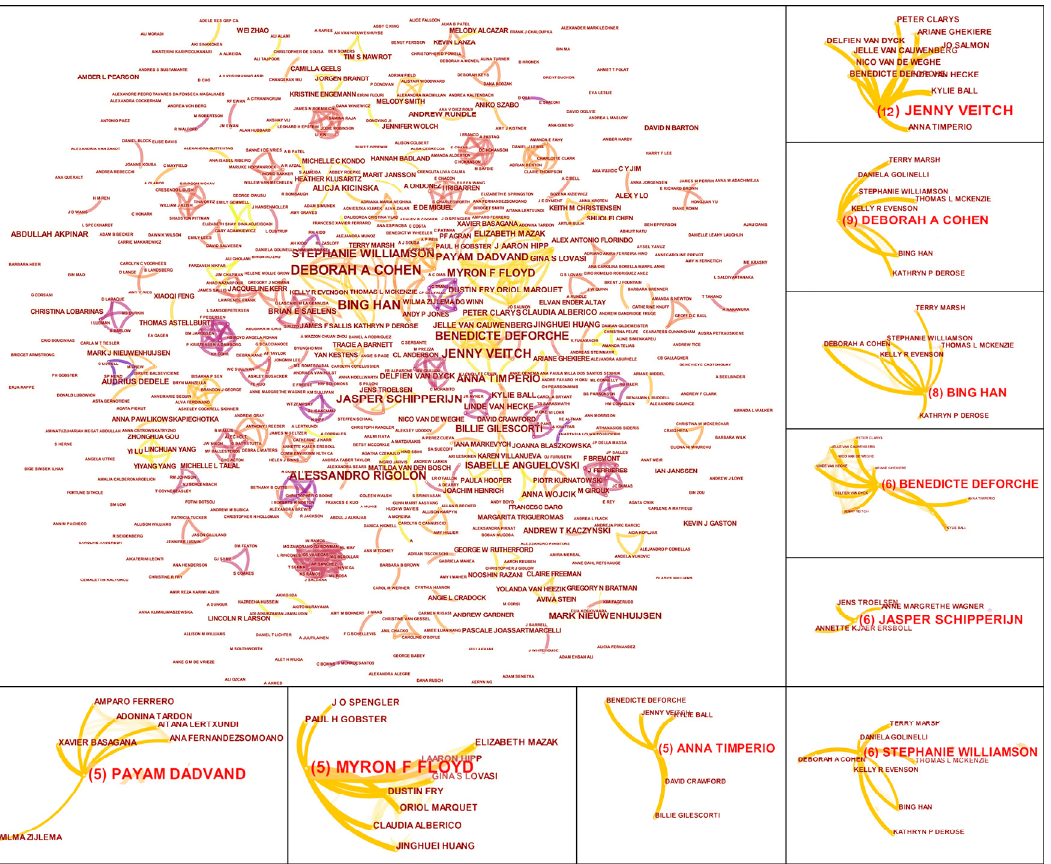
Figure 4. Collaboration network of researchers, and collaboration network of some top researchers.